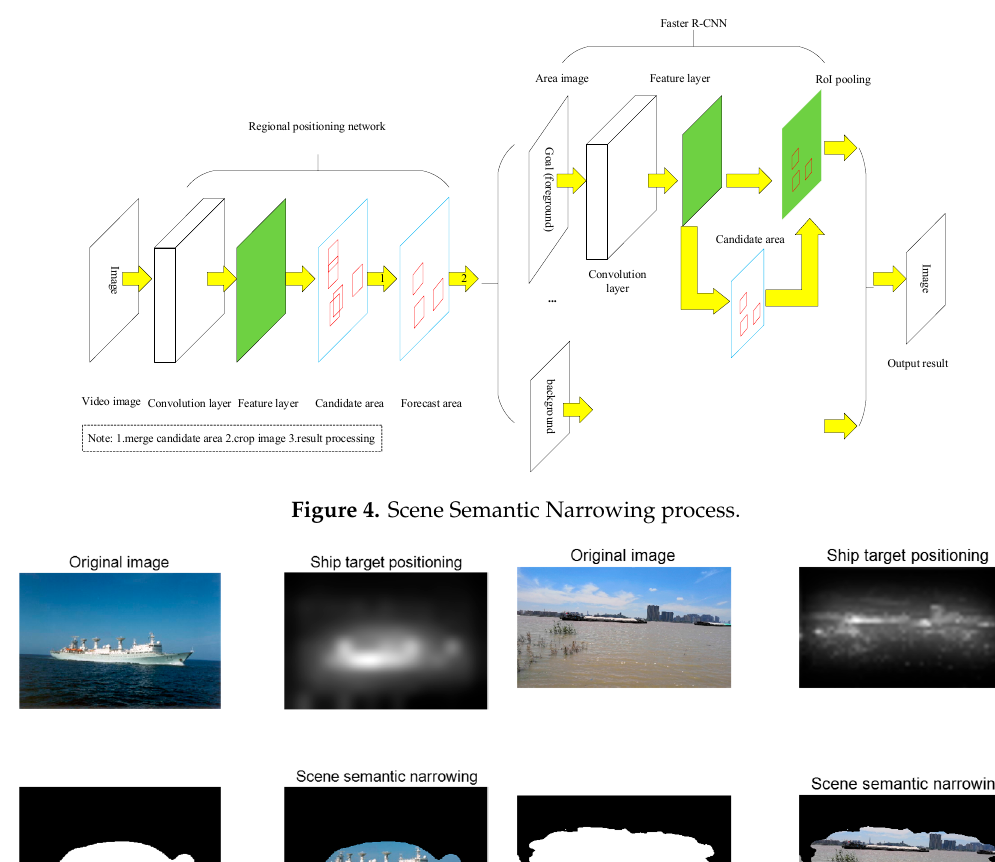
Figure 5. Scene Semantic Narrowing result graph.